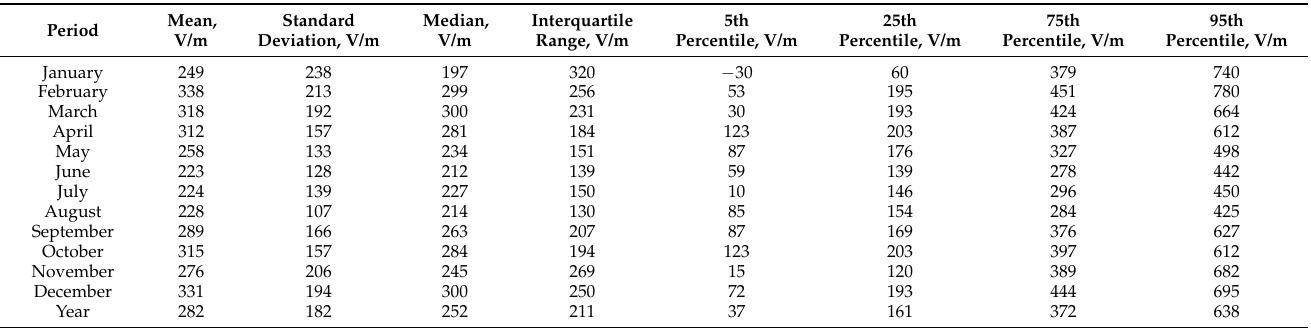
Table A3. Statistical parameters of the total variability in the potential gradient under fair-weather conditions in Tomsk according to data from the IMCES GO for 2006–2020.